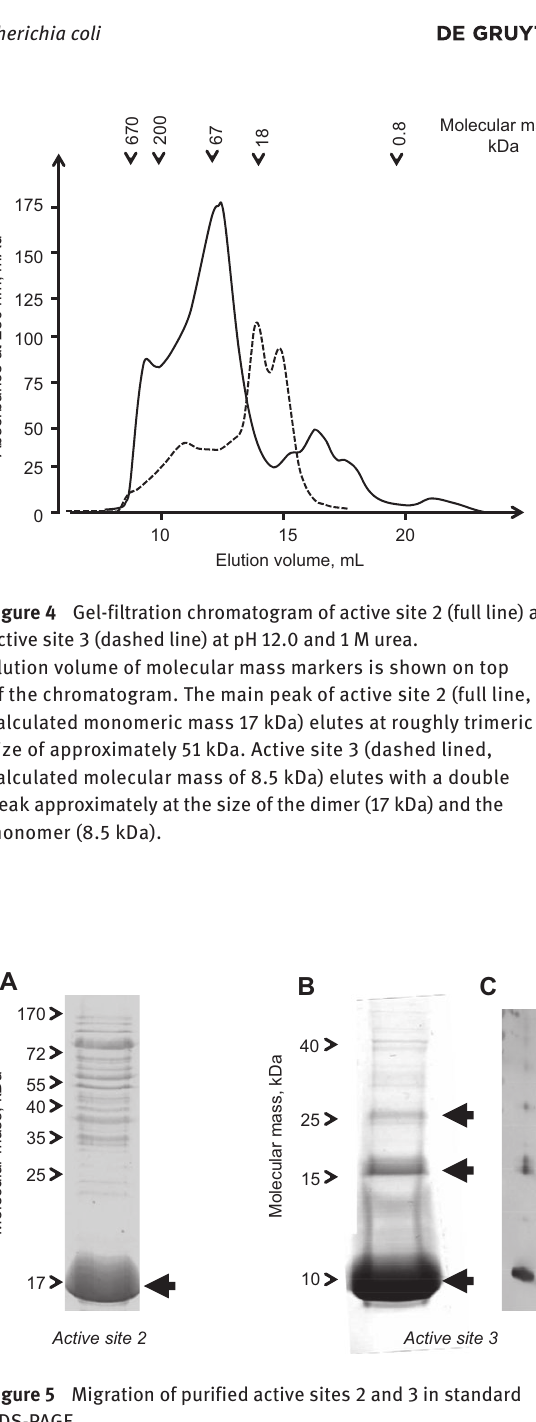
Figure 3 Western blot of resolubilised active site 1, active site 2 and active site 3.